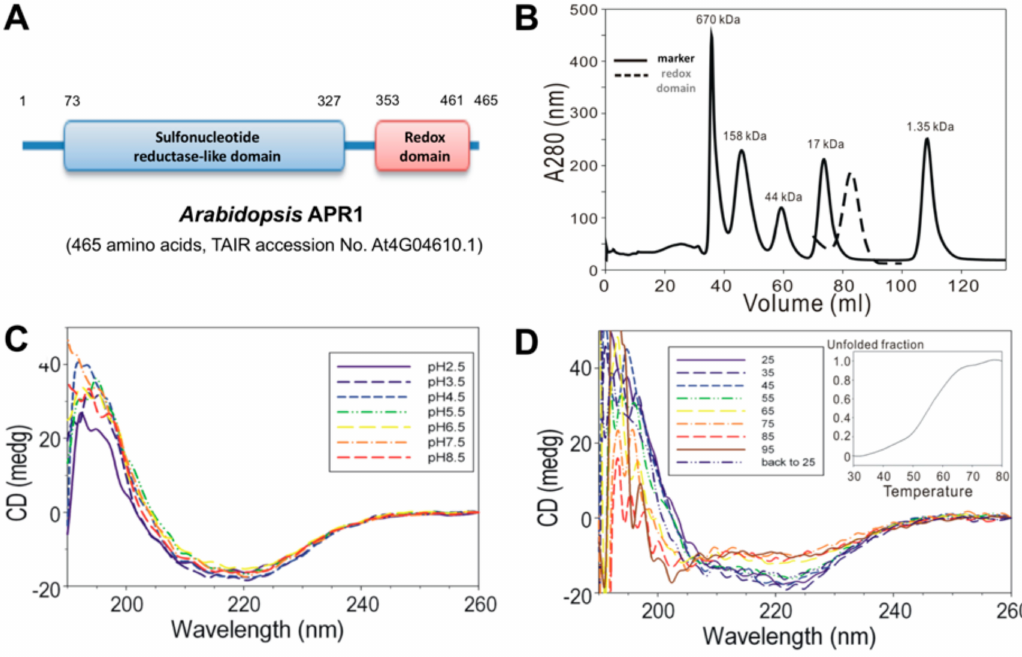
Figure 1. Analysis of biochemical properties of Arabidopsis thaliana APR1 (AtAPR1) C-terminal